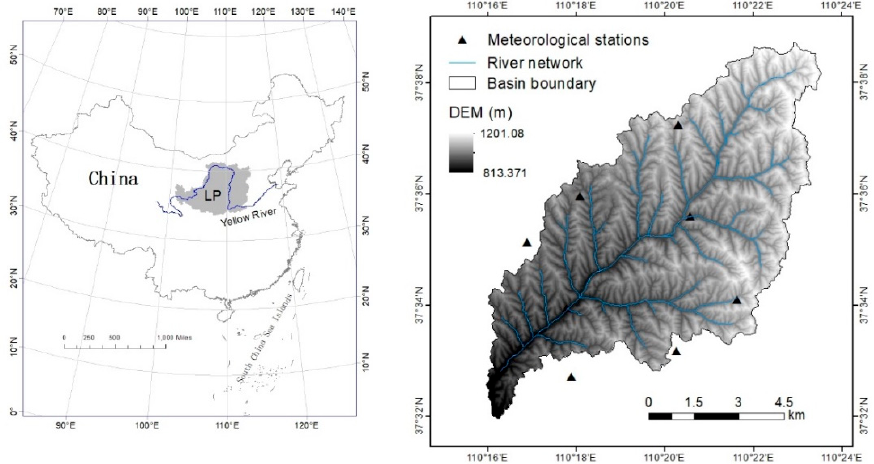
Figure 1. The locations of the Jiuyuangou watershed and LP (Loess Plateau) in China.